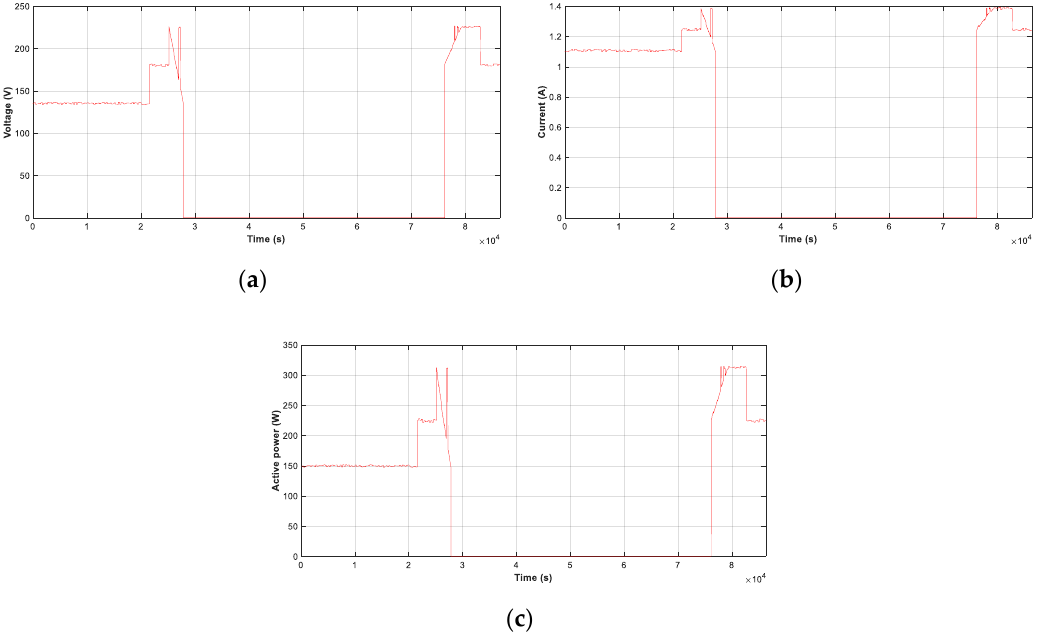
Figure 20. Electrical variables. ( a ) Voltage; ( b ) Current; ( c ) Active power.